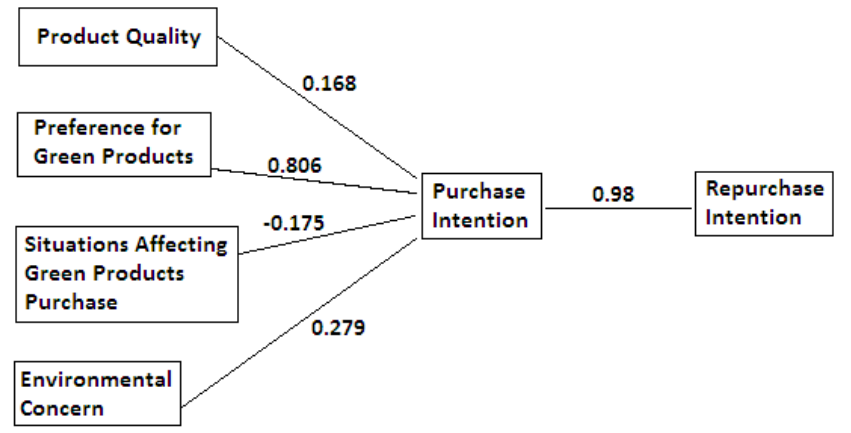
Figure 4: Revised model - consumer perception of green products, purchase behaviour and loyalty